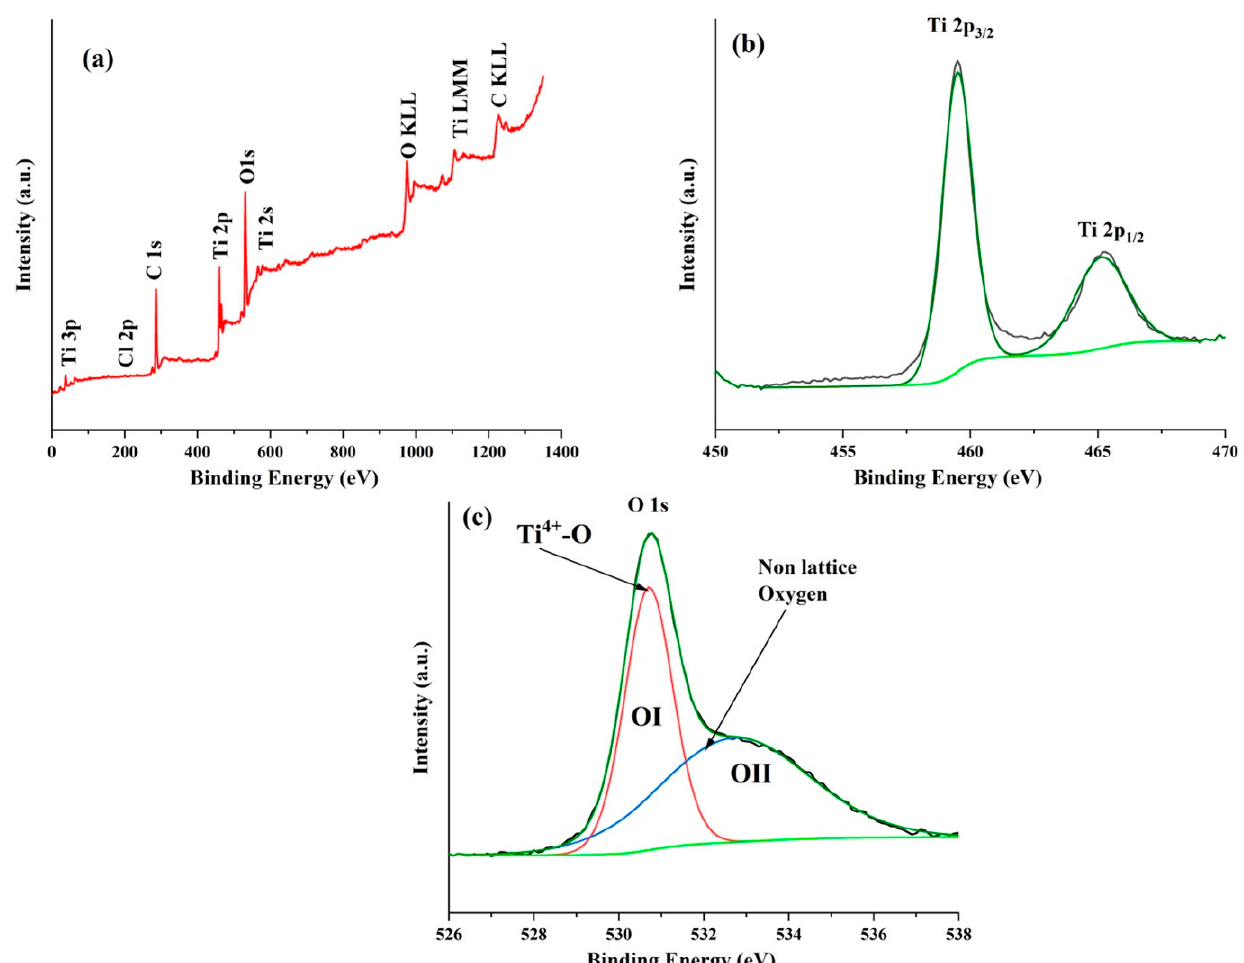
Figure 3. XPS analyses of TiO 2 /Ti mesh. ( a ) Survey scan, ( b ) high-resolution XPS spectrum of Ti 2p core level and ( c ) high-resolution XPS spectrum O 1s core level.